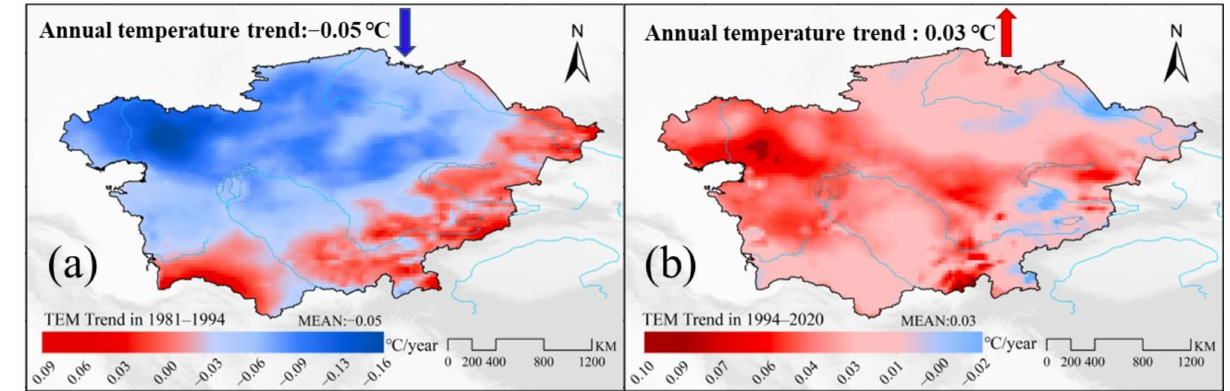
Figure 8. ( a , b ) Temporal and spatial trends of temperature before and after 1994,